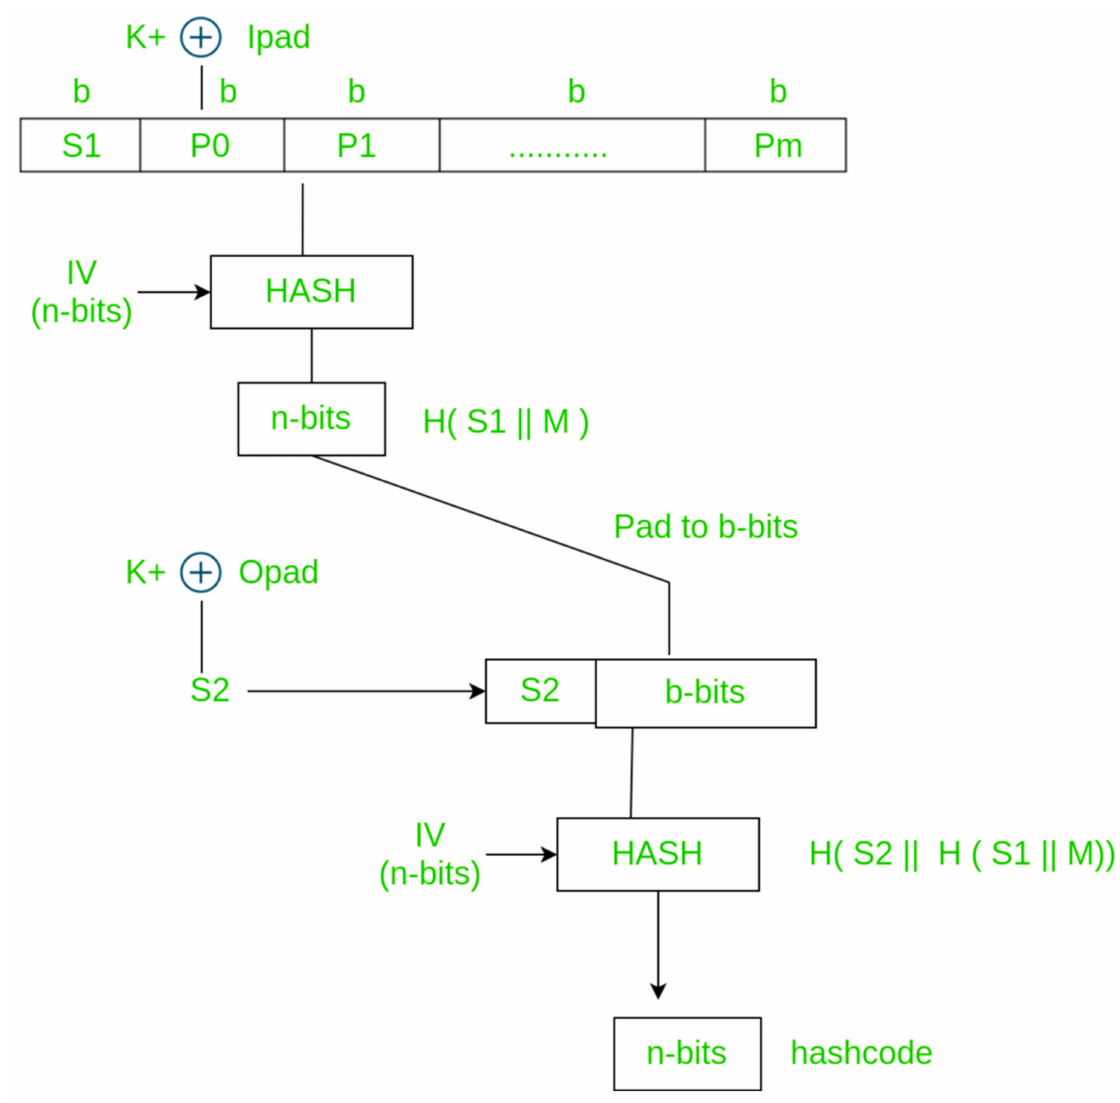
Figure 4. Representation of the HMAC